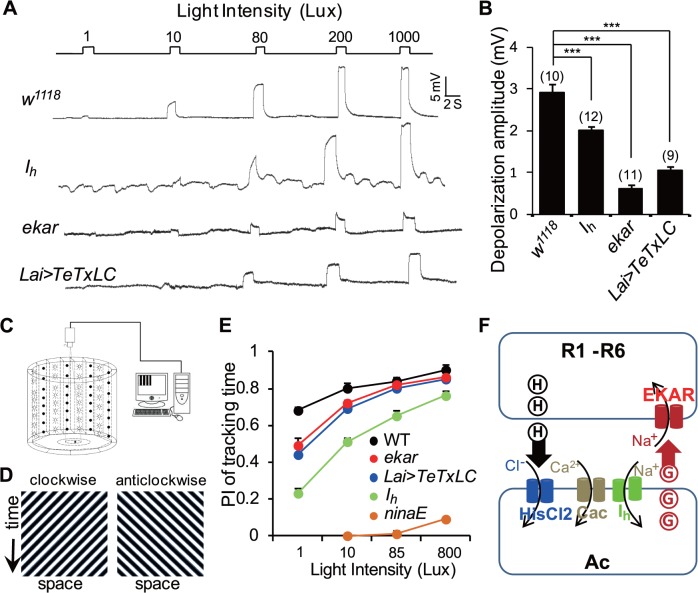
Feedback regulation facilitates visual signal transmission and motion detection in dim light conditions.(A) Intracellular recordings show photoreceptor responses to a series of 1.5-s light pulses with increasing intensity in each genotype. (B) Quantification of 10 Lux light-induced depolarization in each genotype. The numbers of recorded photoreceptors are listed for each genotype, and data are presented as mean ± SEM. (C) Schematic representation of the experimental apparatus. Only half of the LEDs are displayed. (D) Full-field stimuli (180°/s corresponding to a temporal frequency of 4 Hz) used in all behavioral experiments. The space-time diagrams illustrate the luminance patterns displayed to the fly in the arena. (E) Performance index of tracking time. More than 15 flies were examined for each genotype and condition, and the data are presented as mean ± SEM. (F) Model of feedback regulation from ACs to photoreceptors.